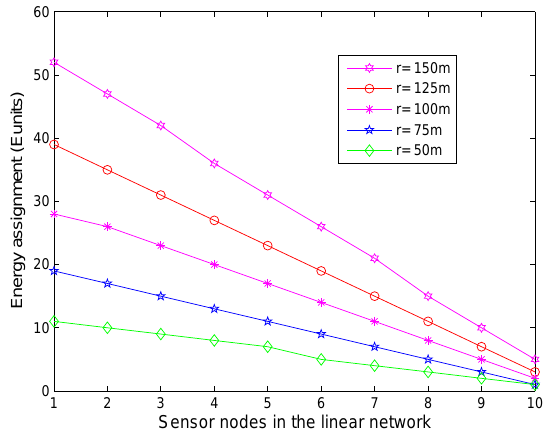
Figure 15. Energy assignment with different internode distance.